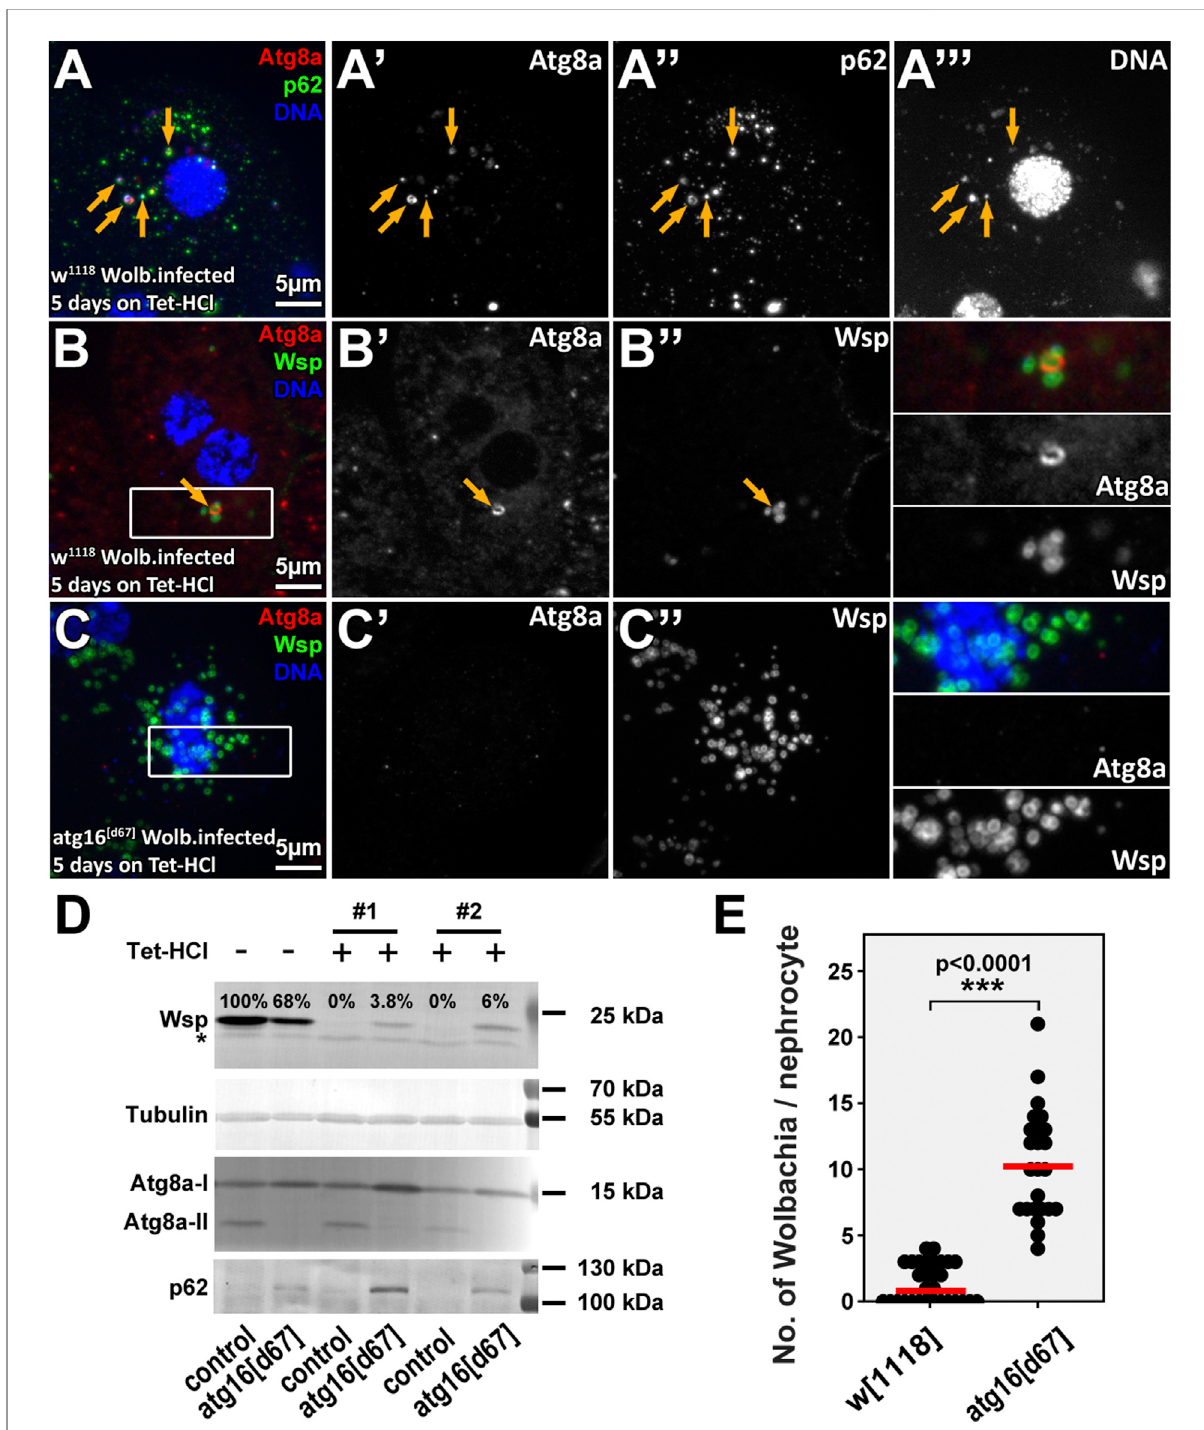
FIGURE 2 Wolbachia cells are eliminated by autophagy in tetracycline treated animals. Rearing animals on tetracycline containing food for a short period results in dispersal of normally perinuclear Wolbachia clusters both in control and atg16 mutant nephrocytes (A – C) . However, control nephrocytes contain (probably dying) Wolbachia cells that are positive for autophagic markers (A,B) , unlike atg16 mutant nephrocytes, in which more bacteria persist and no Atg8a positive membranes can be seen (C,E) . Yellow arrows point to Atg8a-p62-DNA triple positive (A) or Atg8a-Wsp double positive (B) structures. Western blot experiments (D) using larval lysates reveal that Wsp can be still detected in lysates of atg16 mutant larvae by the time by which the control animals become Wolbachia free. The absence of lipidated, autophagosome associated Atg8a (Atg8a-II) and the accumulation of p62 in atg16[d67 ] lysates con fi rm that autophagy is indeed disrupted in mutants and no autophagic membranes are generated.